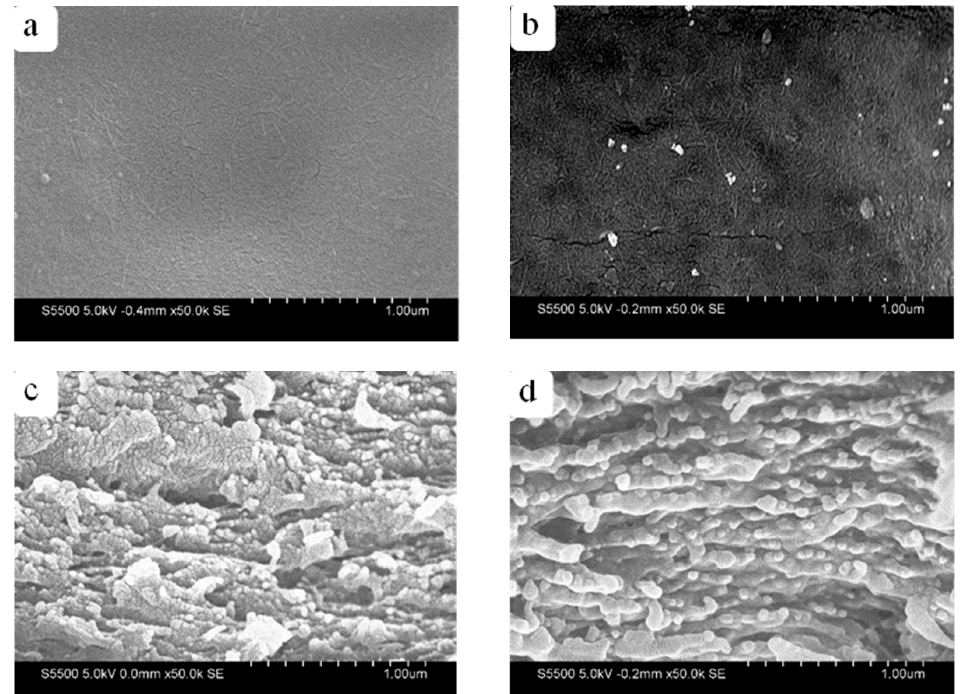
Figure 5. Morphologies of RWSCs prepared by AM and Composite-A films; ( a , b ) surface; ( c , d )